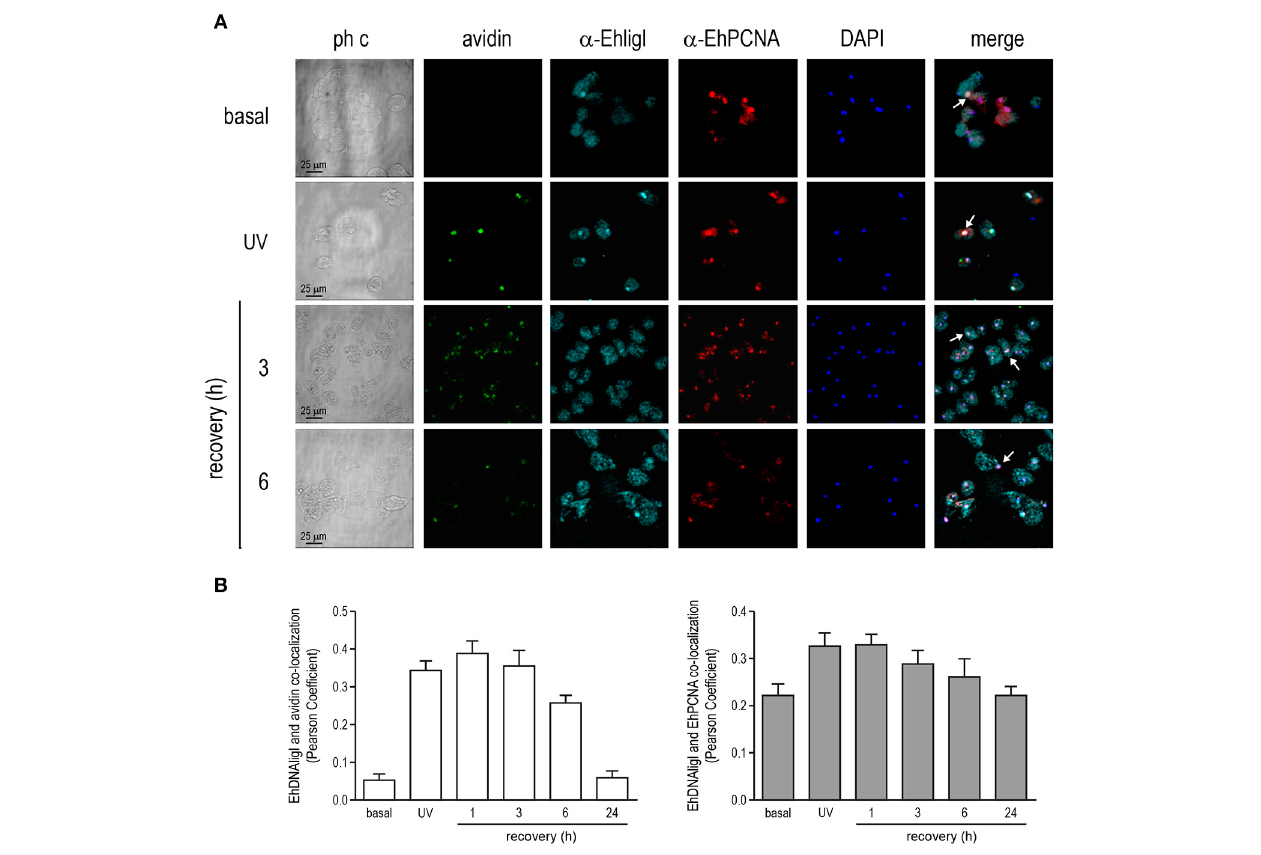
FIGURE 8 | Co-localization of EhDNAligI with EhPCNA after UV treatment. Immunofluorescence assays of trophozoites in basal condition, immediately after treatment with (A) UV (150 J/m 2 ) or at 3 and 6h of recovery, using α -EhDNAligI ( α -EhligI) and α -EhPCNA antibodies coupled to Alexa647 (cyan) and Alexa555 (red), respectively. 8-oxoG presence was detected with avidin-FITC (green). Nuclei were counterstained with DAPI (blue). Confocal microscopy images show a xy -section. ph c: Phase-contrast. Arrows: co-localization of EhDNAligI and EhPCNA. (B) Nuclear co-localization of avidin with EhDNAligI and EhDNAligI with EhPCNA was correlated by Pearson